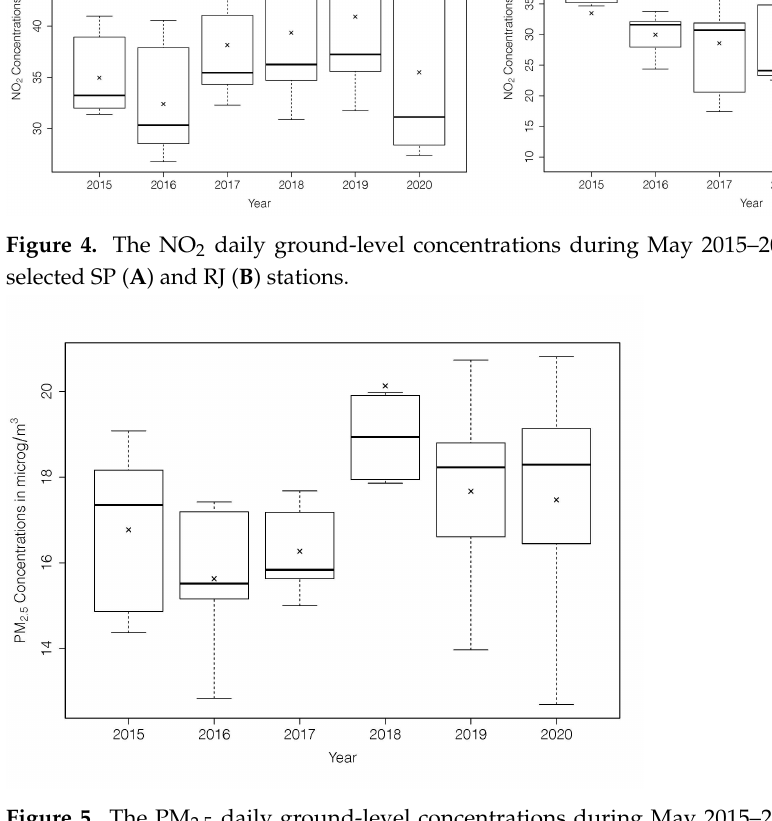
Figure 5. The PM 2.5 daily ground-level concentrations during May 2015–2020 measured by the selected SP